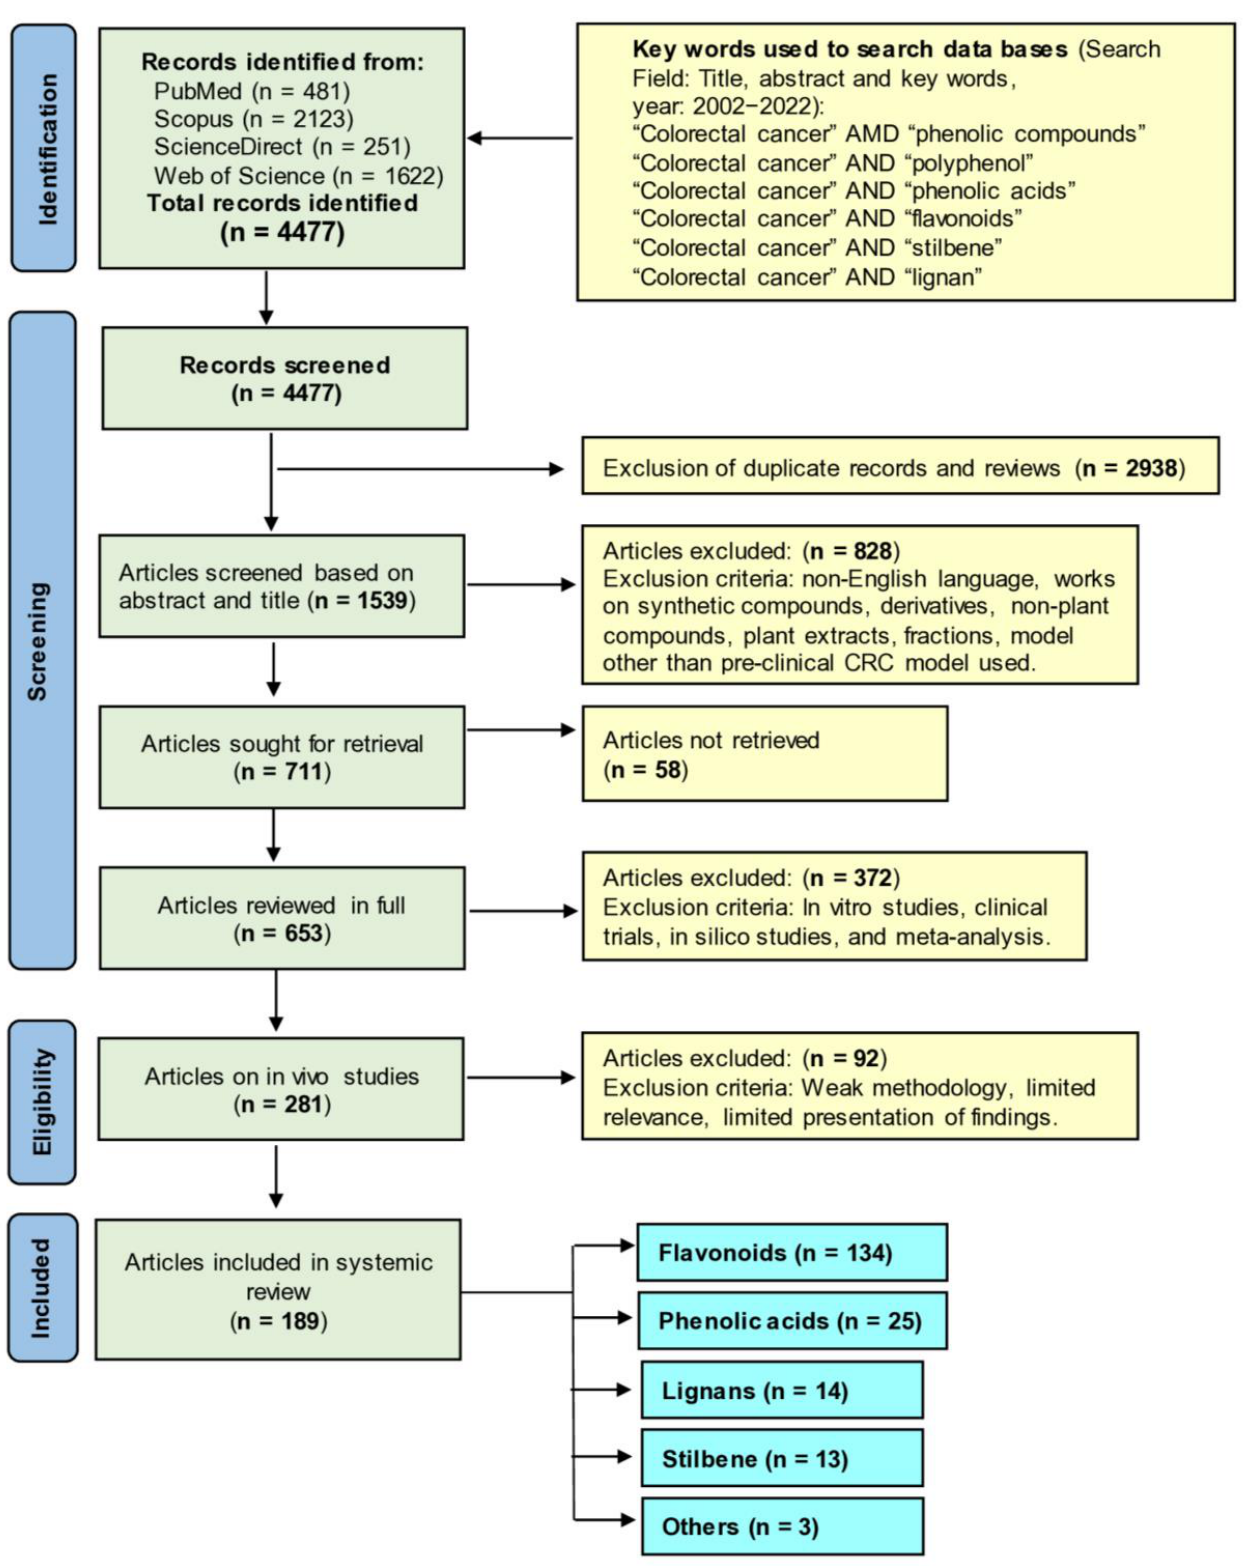
Figure 1. The PRISMA flow chart summarizing the literature search. Here “n” represents the number of articles.